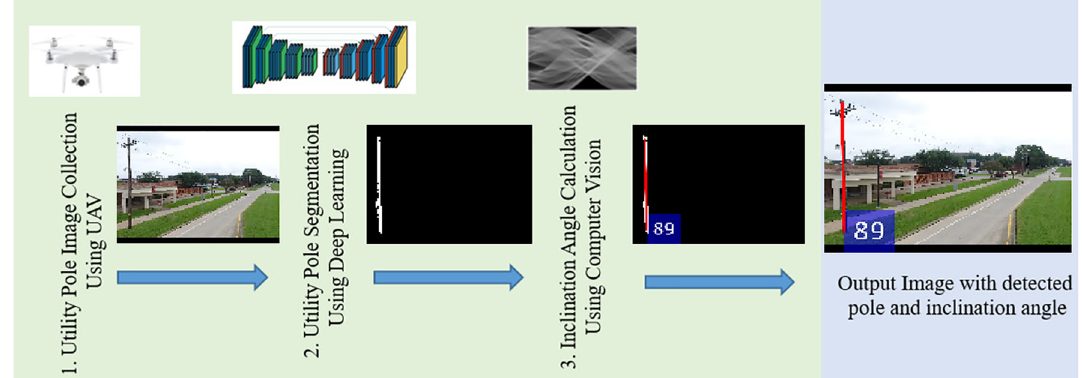
Fig. 2 Flowchart of the proposed method to determine the inclination angle of utility